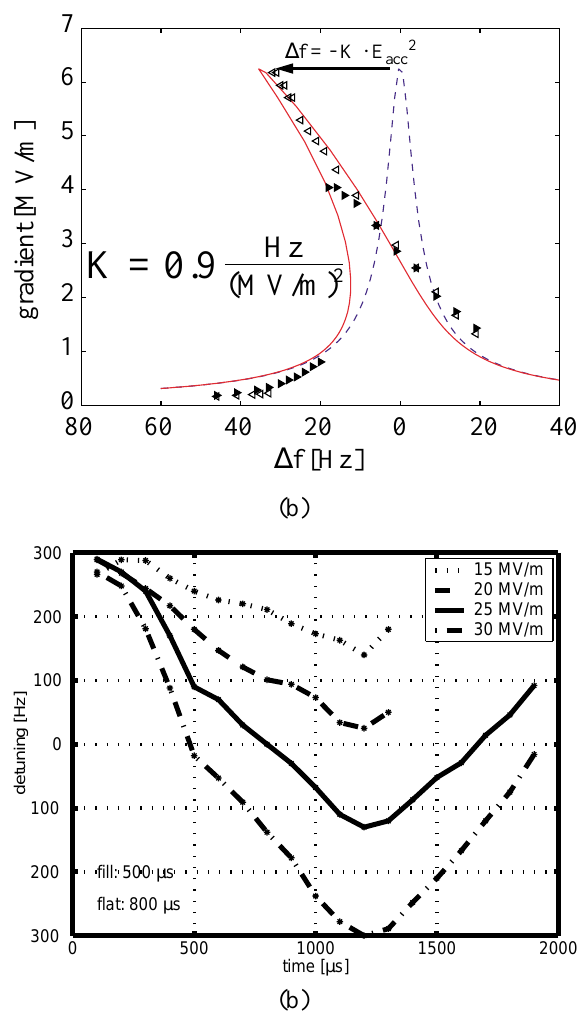
FIG. 26. (Color) (a) Influence of Lorentz forces on the shape of the resonance curve of a sc cavity in cw operation. The left part of the curve was mapped out by approaching the resonance from below, the right part by coming from above. (b) Dynamical detuning of cavity C39 during the TESLA pulse. In pulsed operation the resonance is approached from above.